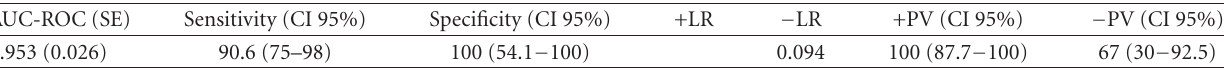
Table 3: Sensitivity, specificity, positive and negative likelihood ratio, and predictive value of ApneaLink plus clinical data for the prescription of CPAP.